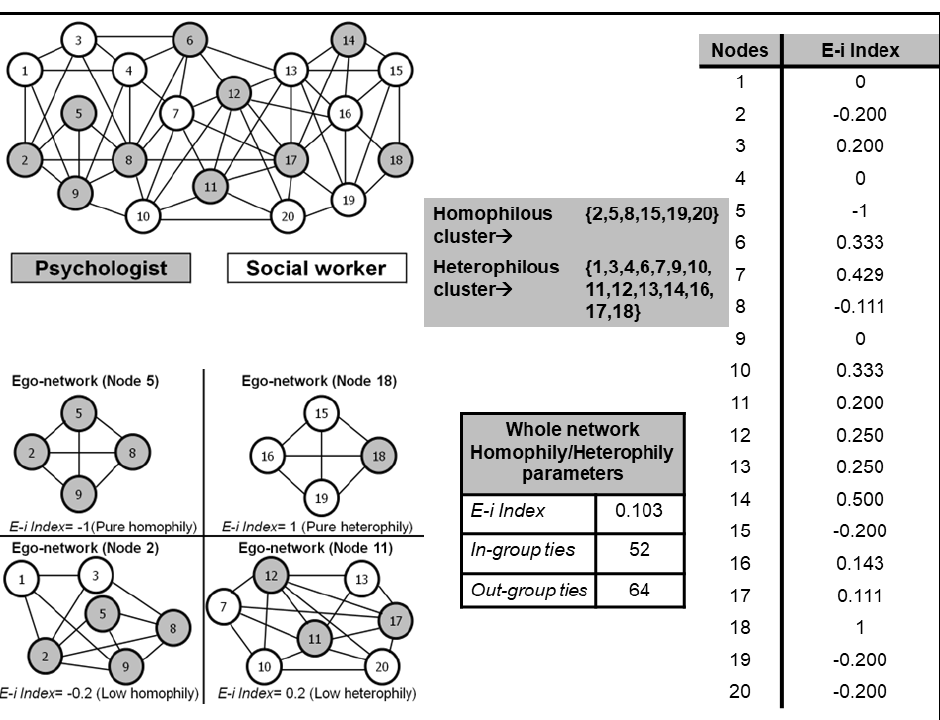
Figure 3. Illustration of homophily/heterophily according to professional profile identifying two clusters using the E-i index as a grouping variable. The lower left quadrant shows the egocentric networks of four professionals depending on the degree of homophily/heterophily of their egocentric network.